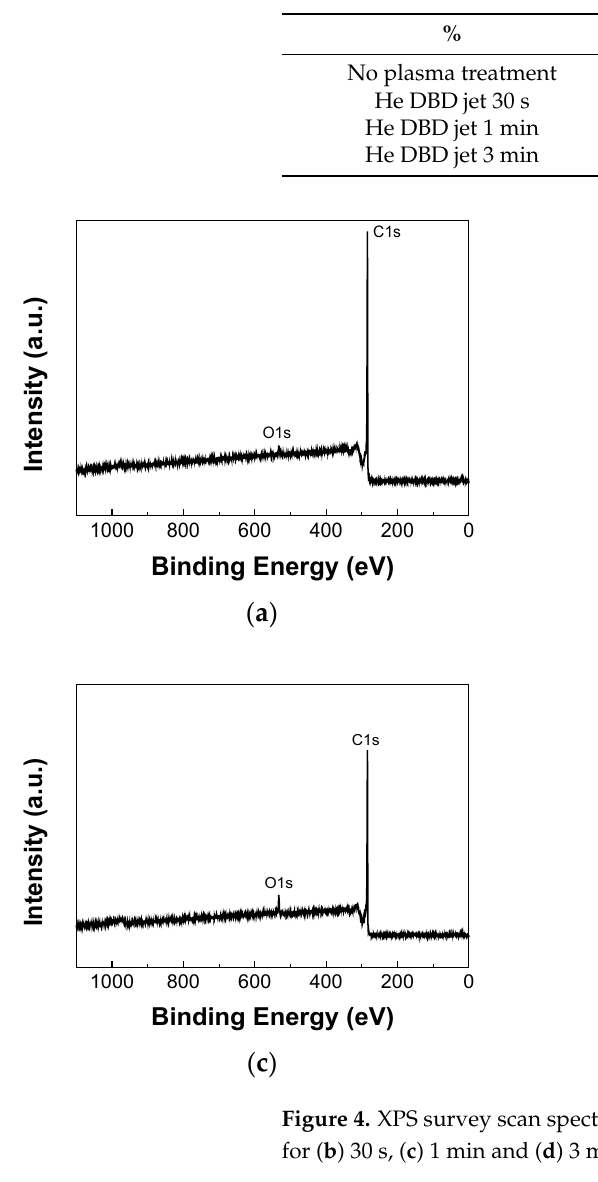
Table 2. XPS deconvolution results for C1s spectra of graphite foil.